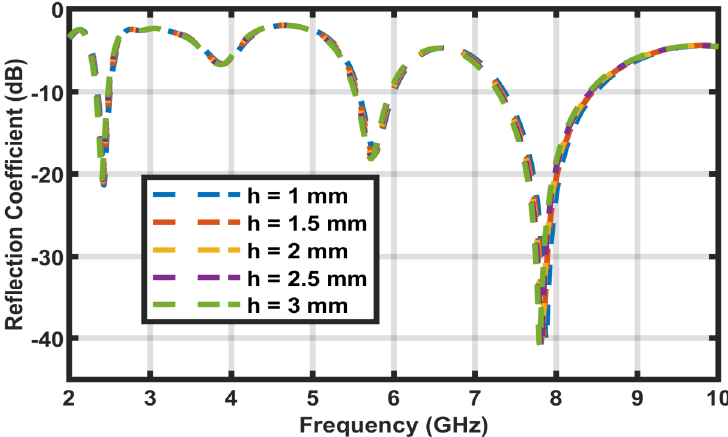
Figure 23. Reflection coefficient of the antenna for various thicknesses of the covering layer.